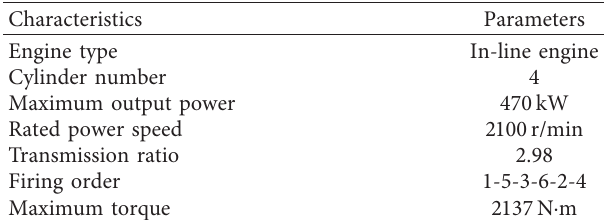
Table 2: Basic parameters of the diesel